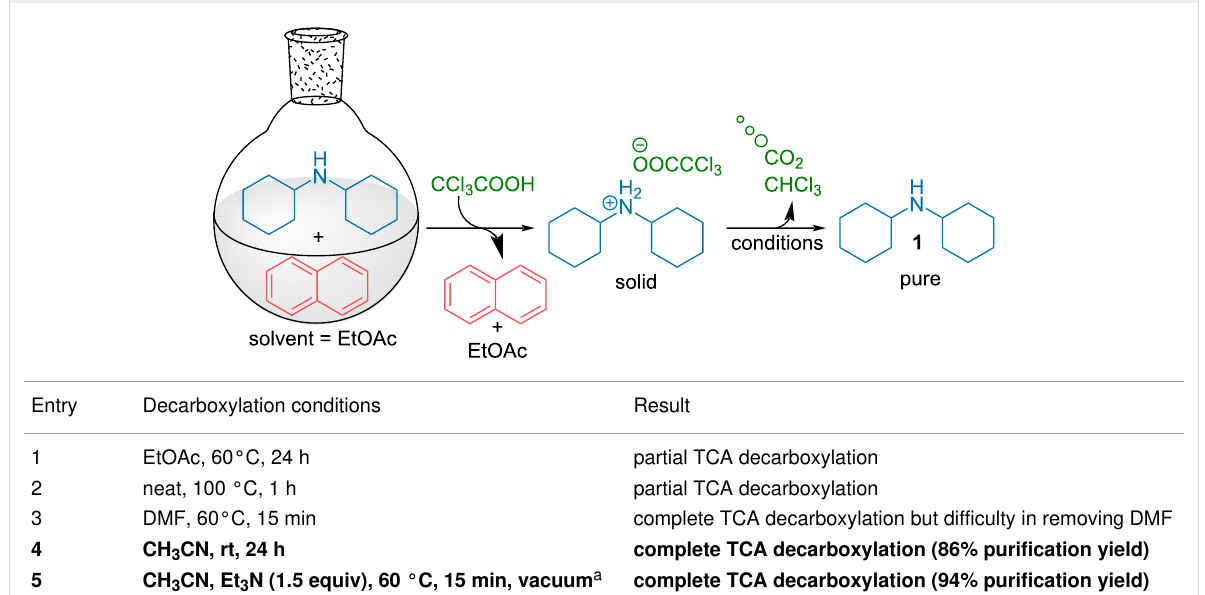
Table 1: Optimization of the